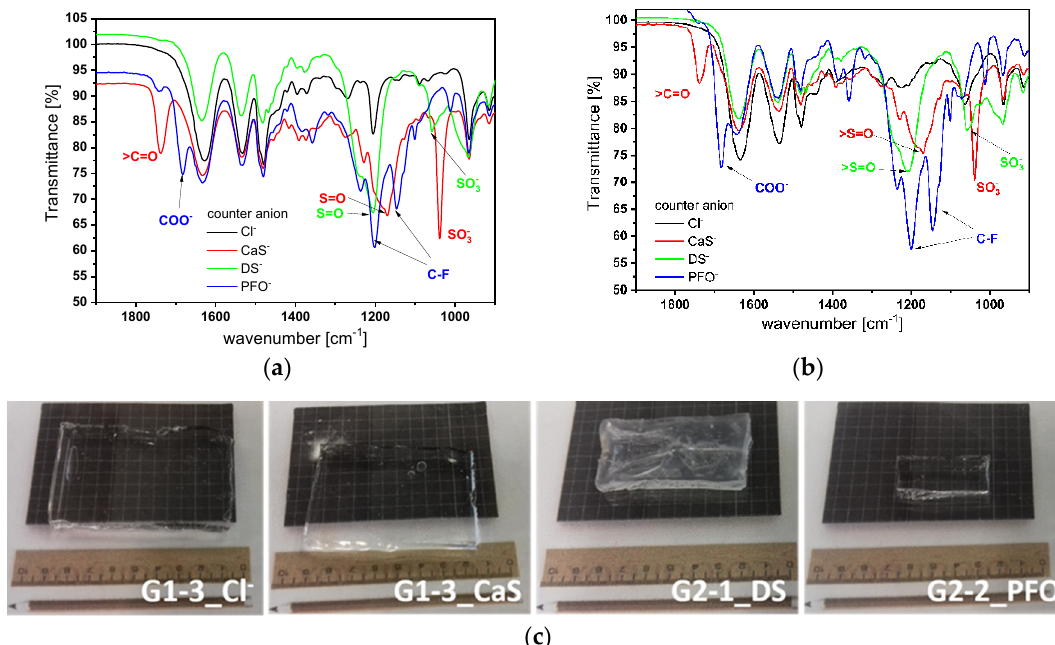
Figure 1. ( a ) FTIR spectra of the hydrogels from ( a ) the G1 series and ( b ) the G2 series, before (with the Cl counterion (black line)) and after the anion exchange equilibrium with CaS (red line), DS (green line) and PFO (blue line); ( c ) representative images of the hydrogels, before and after the exchange of the particular anion. Table 2. Swelling properties of G1 and G2 hydrogels after the anion exchange.